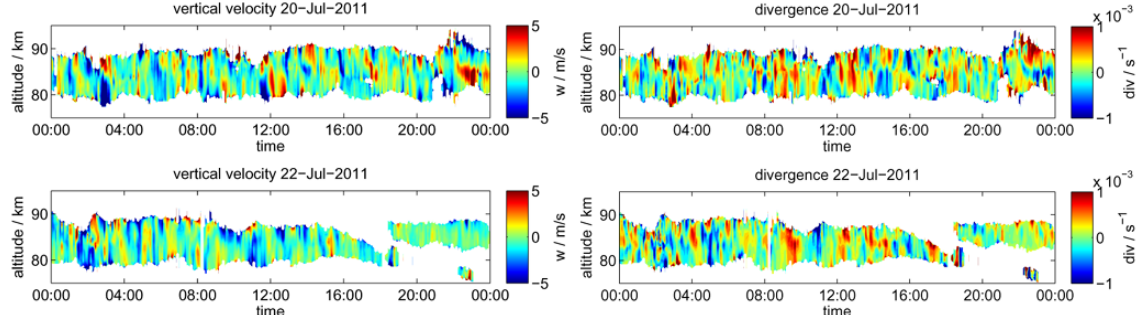
Fig. 6. Observed vertical and horizontal divergence wind from MAARSY measurements using PMSE as tracer for 20 and 22 July 2011. The time is given in